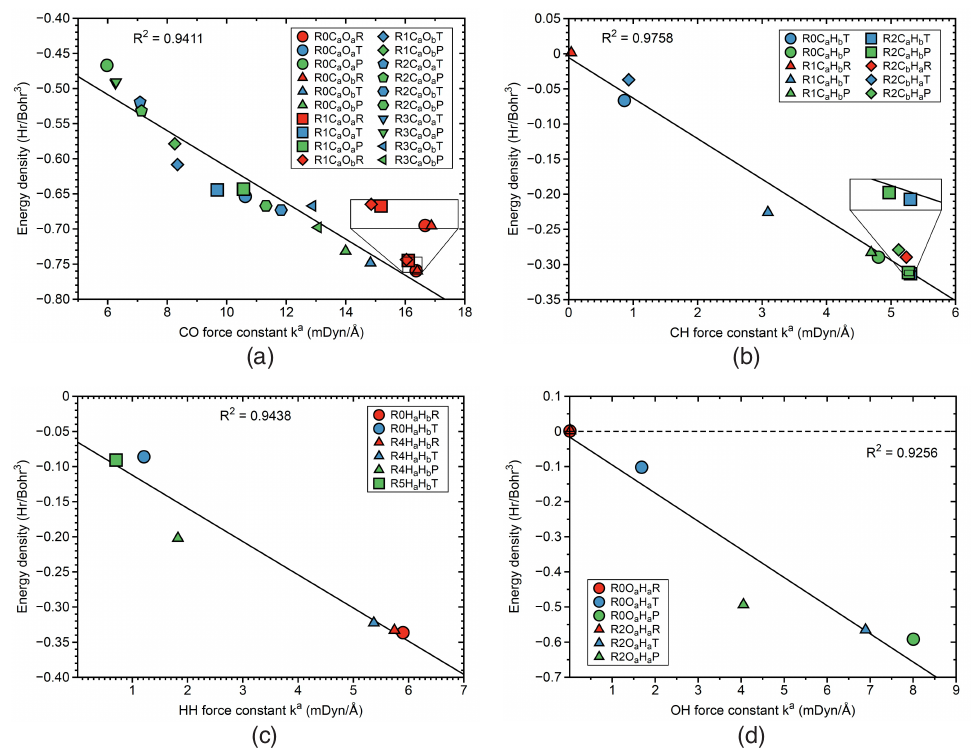
Figure 14. Correlation between energy density H ρ and local mode force constant k a . ( a ) CO bonds; ( b ) CH bonds; ( c ) HH bonds; ( d ) OH bonds. Labels such as R0C a O a R, R0C a O a T, and R0C a O a P indicate reactant RE (red color), TS (blue color), and product PR (green color) C a O a in reaction R0 . Similar notation for reactions R1 – R5 . For the bond label description see the text. B3LYP/6-31G(d,p)/SDD(Ir) level of theory.